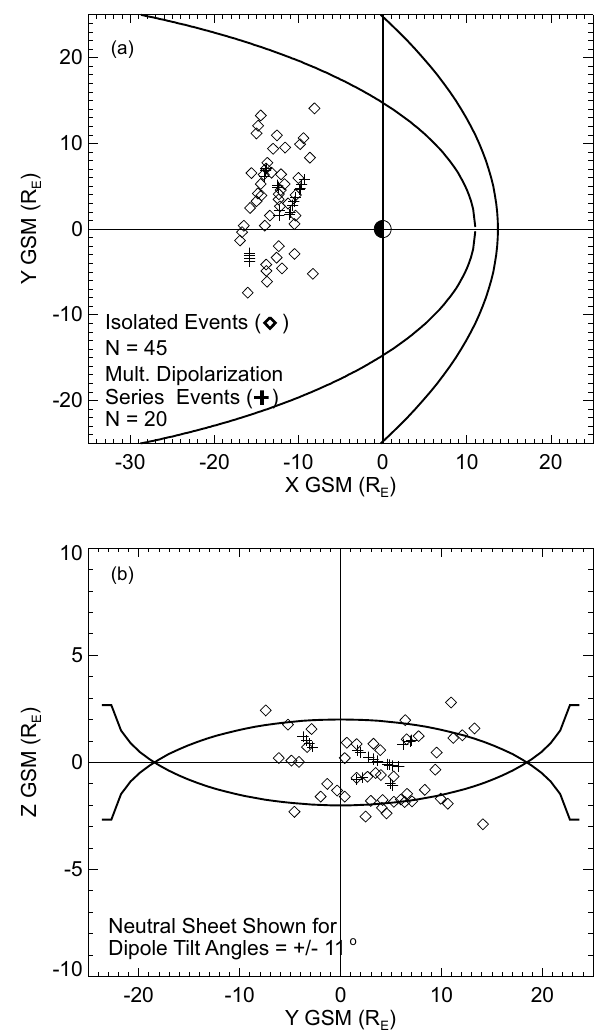
Fig. 8. The spatial distribution of the 45 isolated dipolarization events and 20 multiple dipolarization series events observed by Wind in ( a ) the X − Y and ( b ) the Y − Z GSM planes. Isolated dipo- larization events were defined as dipolarization events occurring at least 20min after the last dipolarization event and at least 20min be- fore the next dipolarization event. Dipolarization events that were spaced less than 20min apart were considered to be part of a multi- ple dipolarization series. The two curves plotted in the Y − Z plane represent the Fairfield (1980) neutral sheet for dipole tilt angles of ± 11 ◦